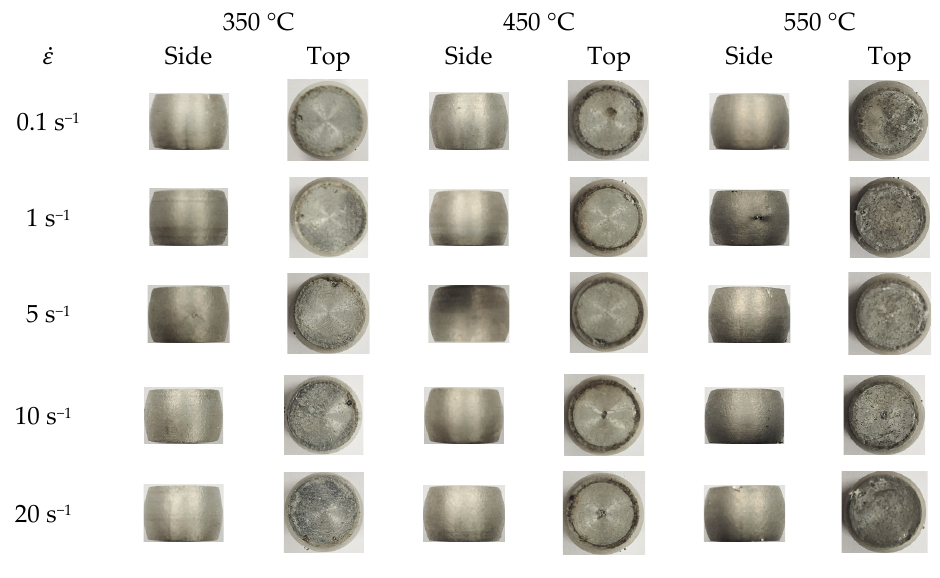
Figure 1. Selected A6082 alloy specimens. Table 1. Measured height ( h ) and minimum ( d n ) and maximum ( d x ) diameters of the specimens.